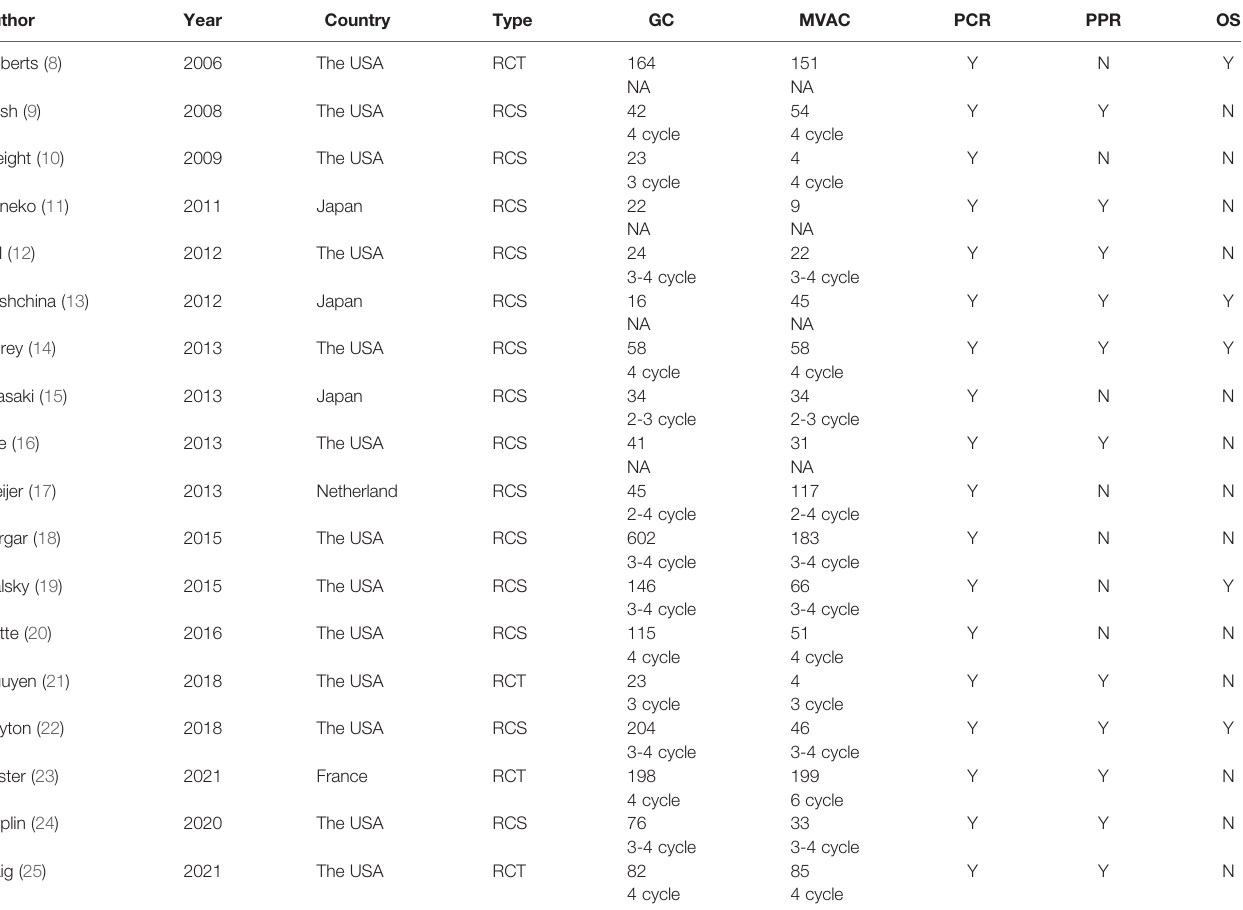
TABLE 1 | Baseline characteristics of included